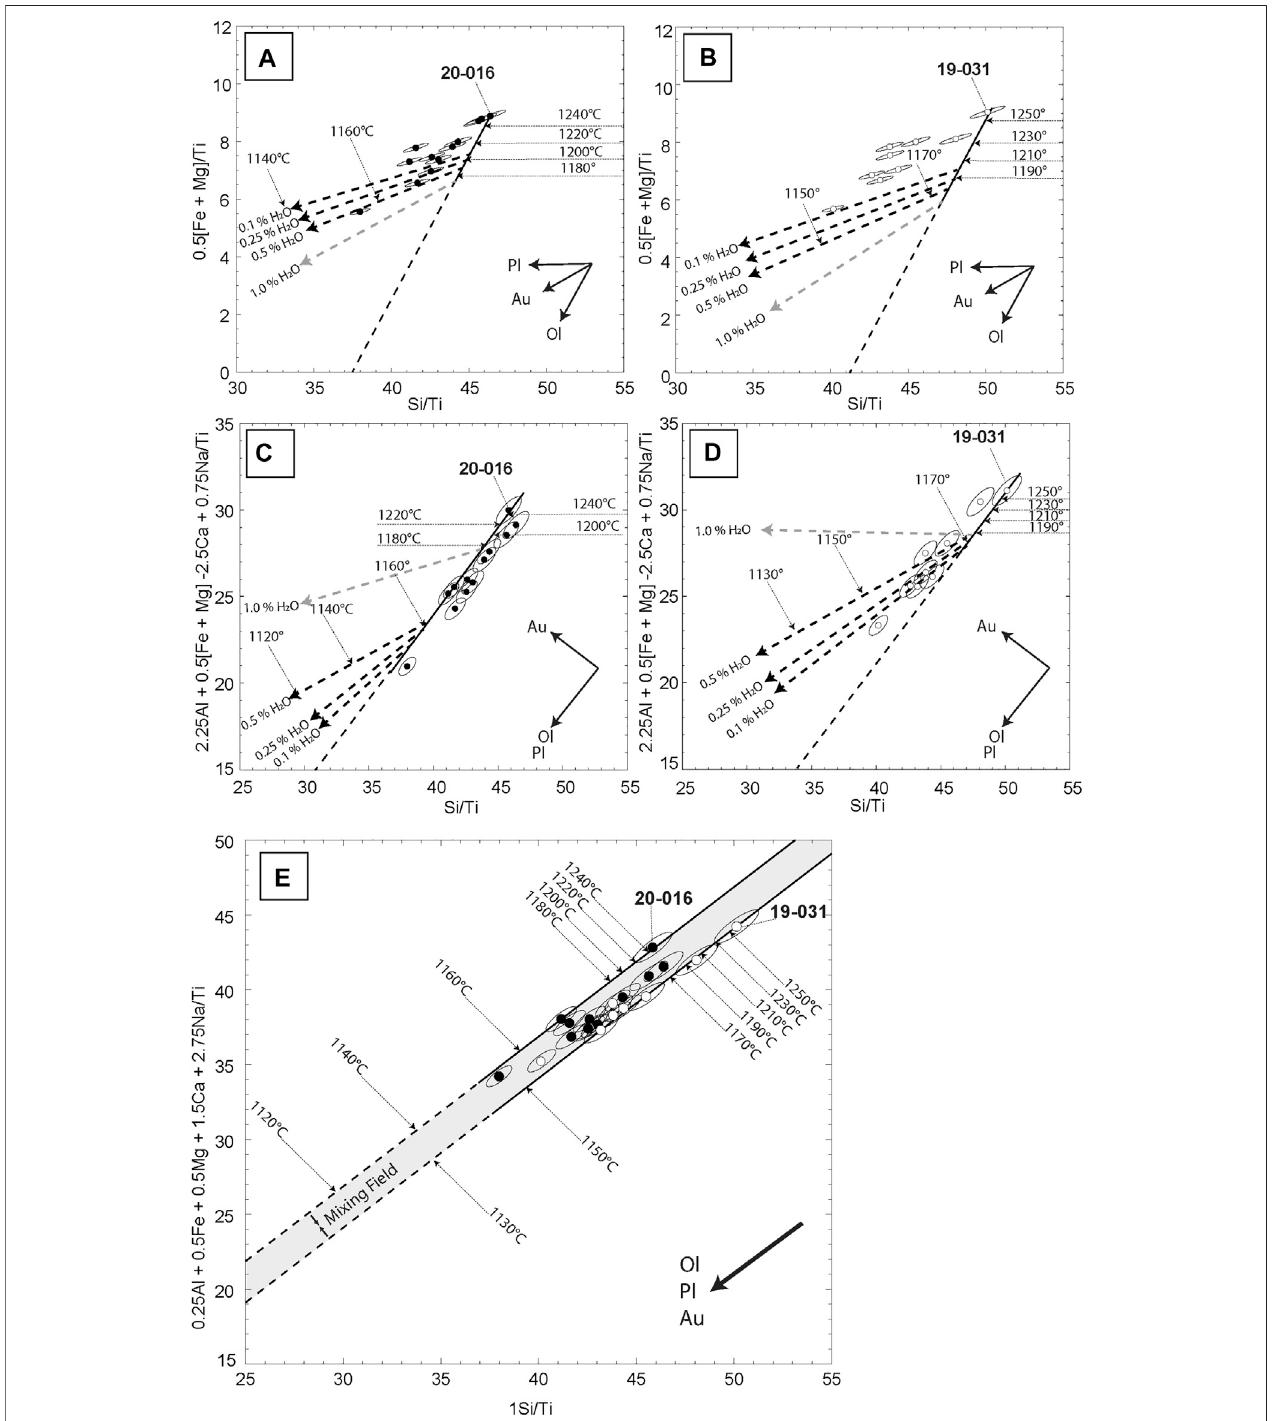
FIGURE8| ThermodynamicconditionsformagmaticdifferentiationatCMillustratedwithPERsandmodeledwithRhyolite-MELTS(samesymbologyasin Figures 6 , 7 ).Sample20-016waschosenasaproxyforOPsamplesandMELTsimulationswererunat1.5 kbarfrom1to0.1%H 2 O.Sample19-031waschosenasaproxyfor OPAsamples,andMELTsimulationswererunat2 kbarfrom1to0.1%H 2 O.DiagramsareformattedasPERs,withaxesdesignedtotestforsortingprocessesinvolving olivine (Ol) (A,B) , Ol and plagioclase (Pl) (C,D) , and Ol and Pl and augite (Au) (E) . Liquidus lines of ascent are shown for various H 2 O% conditions plotted at 20 ° C intervals. Models run at 0.5% H 2 O have temperature intervals labeled in the PER space. Simulations indicate that for both phenocryst assemblages (i.e., OP and OPA) less than 0.5% H 2 O is required to follow the cotectic (in fl ection-points) trends of fractional crystallization modeled by the PERs.